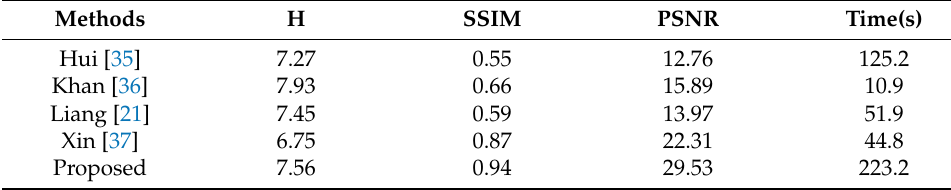
Table 5. Average objective values of 50 high-brightness